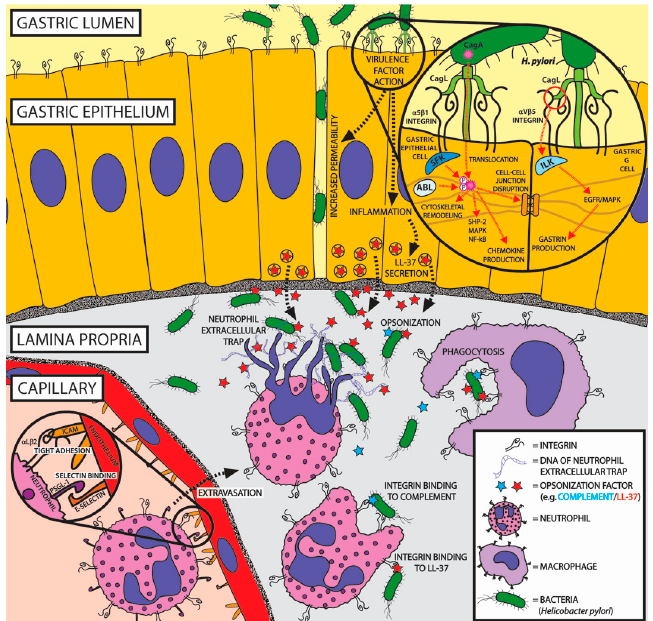
Figure 2. Integrins act as “double agents” during Helicobacter pylori infection in the stomach, serving to potentiate bacterial pathogenicity while also aiding in the immune response. H. pylori bacteria